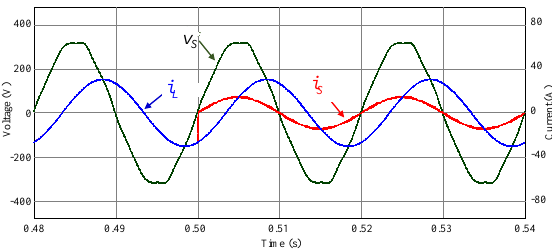
Figure 11. Transient analysis of the SAPF starting of compensation with linear Resistive-Inductive (RL) Load.